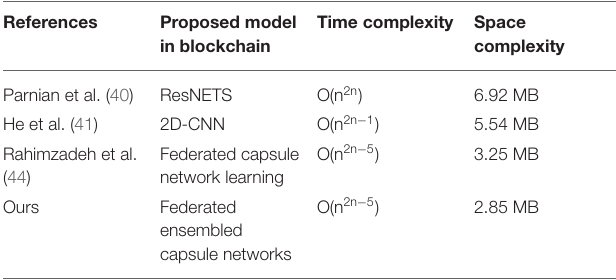
TABLE 8 | Comparative analysis between the blockchain-based model with other